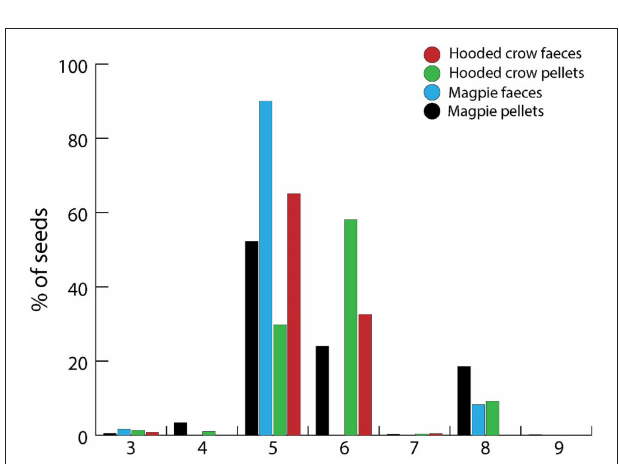
FIGURE 8 | Relative abundance of intact seeds recovered from pellet and fecal samples of Magpies and Hooded Crows by Heintze assigned to different Ellenberg moisture indicator values ( F ). This scale goes from 1 (dry soils) to 12 (submerged macrophytes). For Ellenberg 9 there was only 1 seed (0.02% of the total) of alder Alnus glutinosa from a Magpie pellet. See Figure 7 for sample